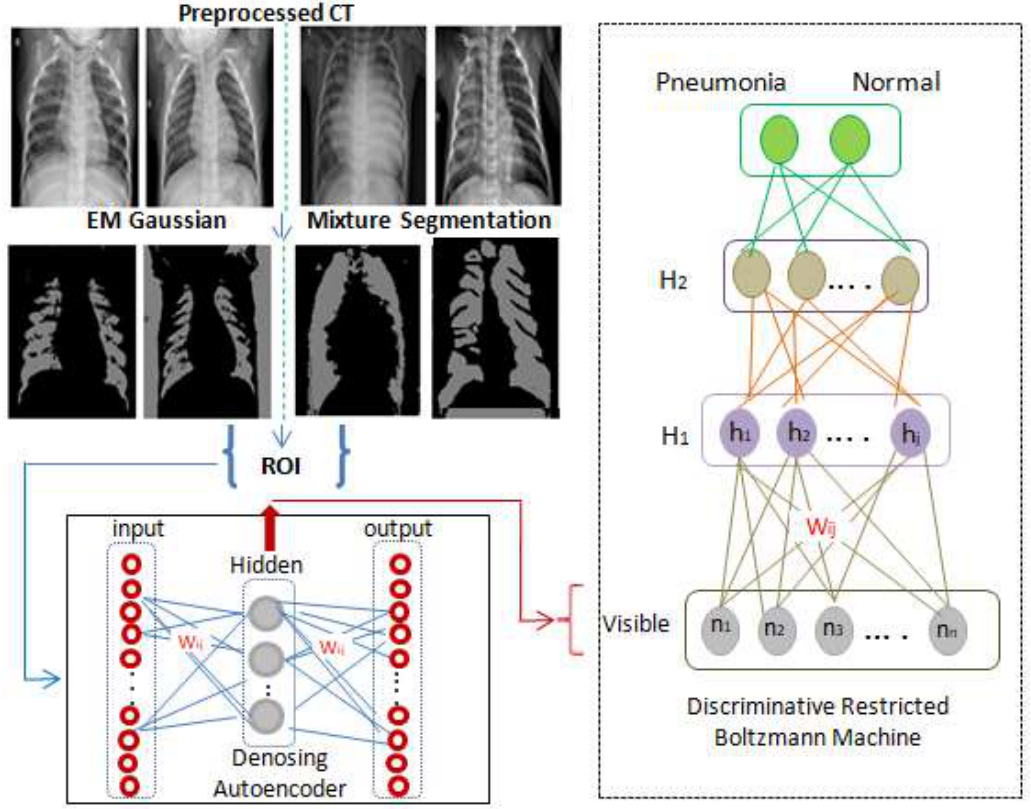
Figure 1. Illustration of the proposed EMGMM-AEDRBM model for a two class classification problem: “Visible layer” for the input layer and “h” for the hidden layer.